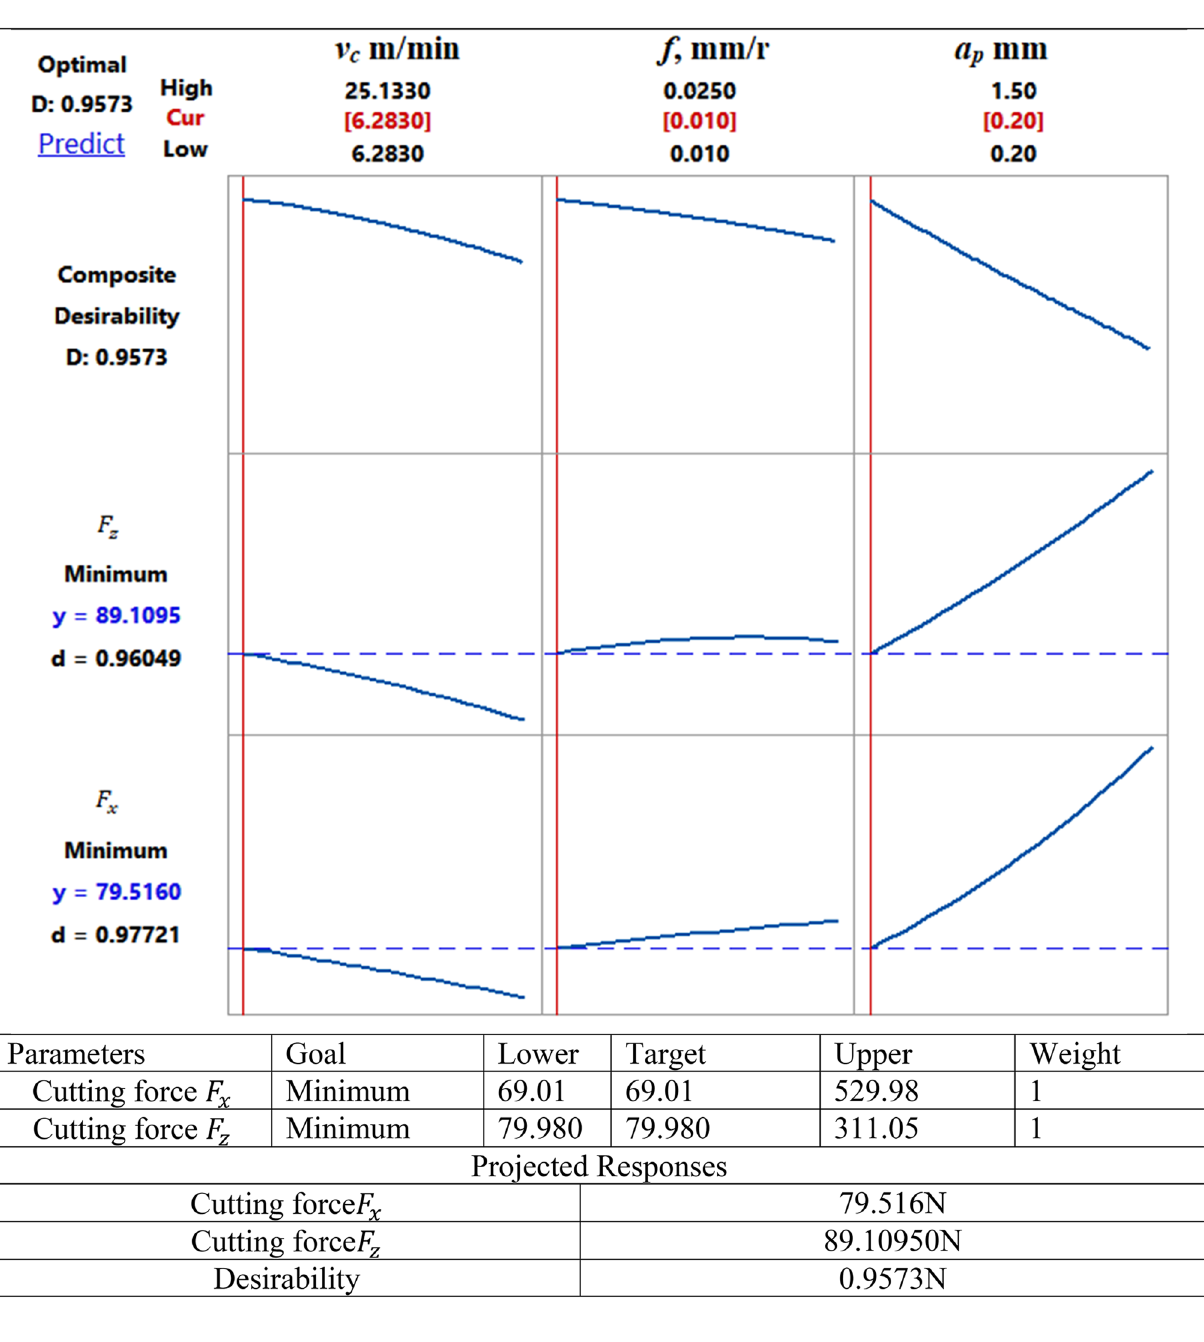
Fig. 18 Optimization Plots of Cutting Force F x and F z SiCp/Al